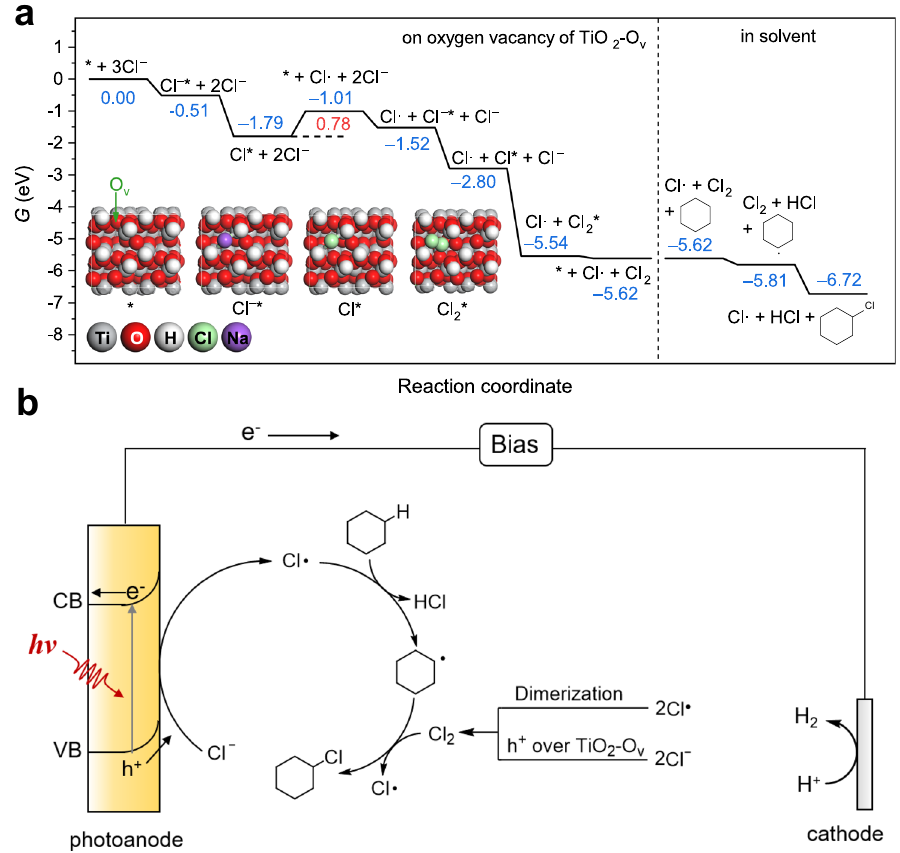
Fig. 6 DFT calculations of the PEC cyclohexane chlorination and proposed mechanism. a Gibbs free energy diagram for the adsorption of Cl – , generation of Cl* and Cl 2 *, and their further desorption to Cl· and Cl 2 on TiO 2 -O v , together with the chlorination of cyclohexane by Cl· and Cl 2 . The Gibbs free energies ( Δ G ) of reactant, intermediates, and product are labeled with blue numbers in brackets with the unit of eV. The Δ G of the potential determining step, desorption of Cl*, is labeled in red number with the unit of eV. The top views for the reaction intermediates, * (the reaction site of oxygen vacancy is highlighted with green circle), Cl – *, Cl*, and Cl 2 *, are also displayed with the color of each element labeled. b Proposed mechanism of PEC chlorination of cyclohexane over TiO 2 -O v -400